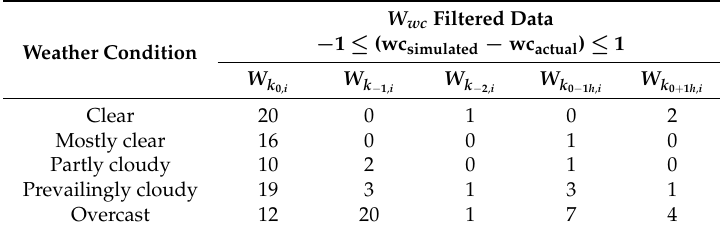
Table 2. Weights for the corresponding forecasted weather